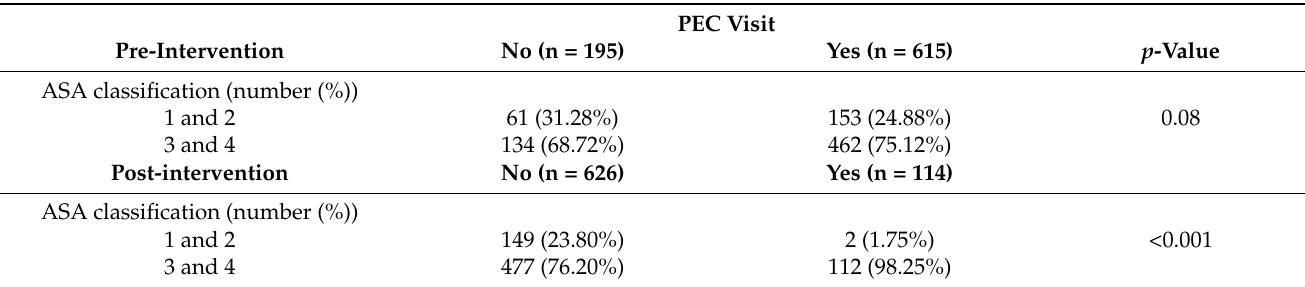
Table 4. Pre-operative evaluation center visits by ASA